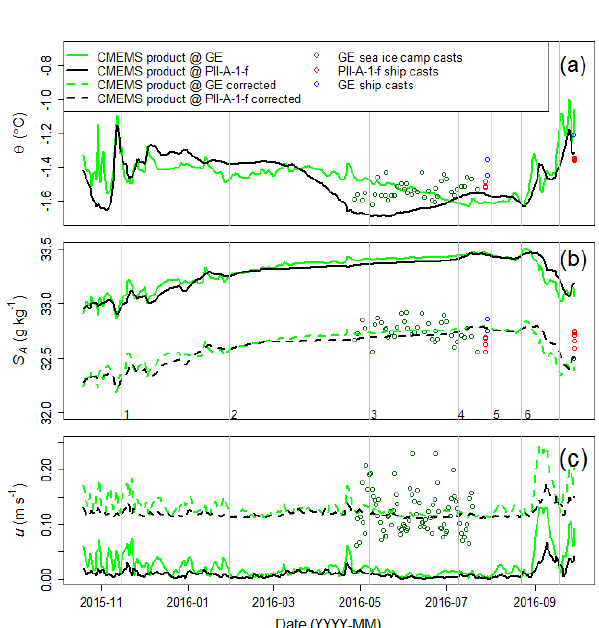
Figure 4. Oceanographic data collected or modelled over the time span that PII-A-1-f basal ablation rates were derived. CMEMS product data for the grid cells in which PII-A-1-f (solid black lines) and the GreenEdge sea ice camp (solid green lines) were located: (a) conservative temperature ( (cid:50) ), (b) absolute salinity ( S A ), and (c) velocity ( u ). As PII-A-1-f was grounded, u is equivalent to the dif- ferential velocity between the ice island and the ocean current. Field data collected by the CCGS Amundsen and the GreenEdge project are shown in the respective panels. The CMEMS data, corrected for bias in S A and u , are shown as dotted lines in (b) and (c) , respec- tively. The vertical lines denote the calibration intervals, numbered in (b) , associated with thickness change measurements that were used for the calibration of the forced convection basal melt